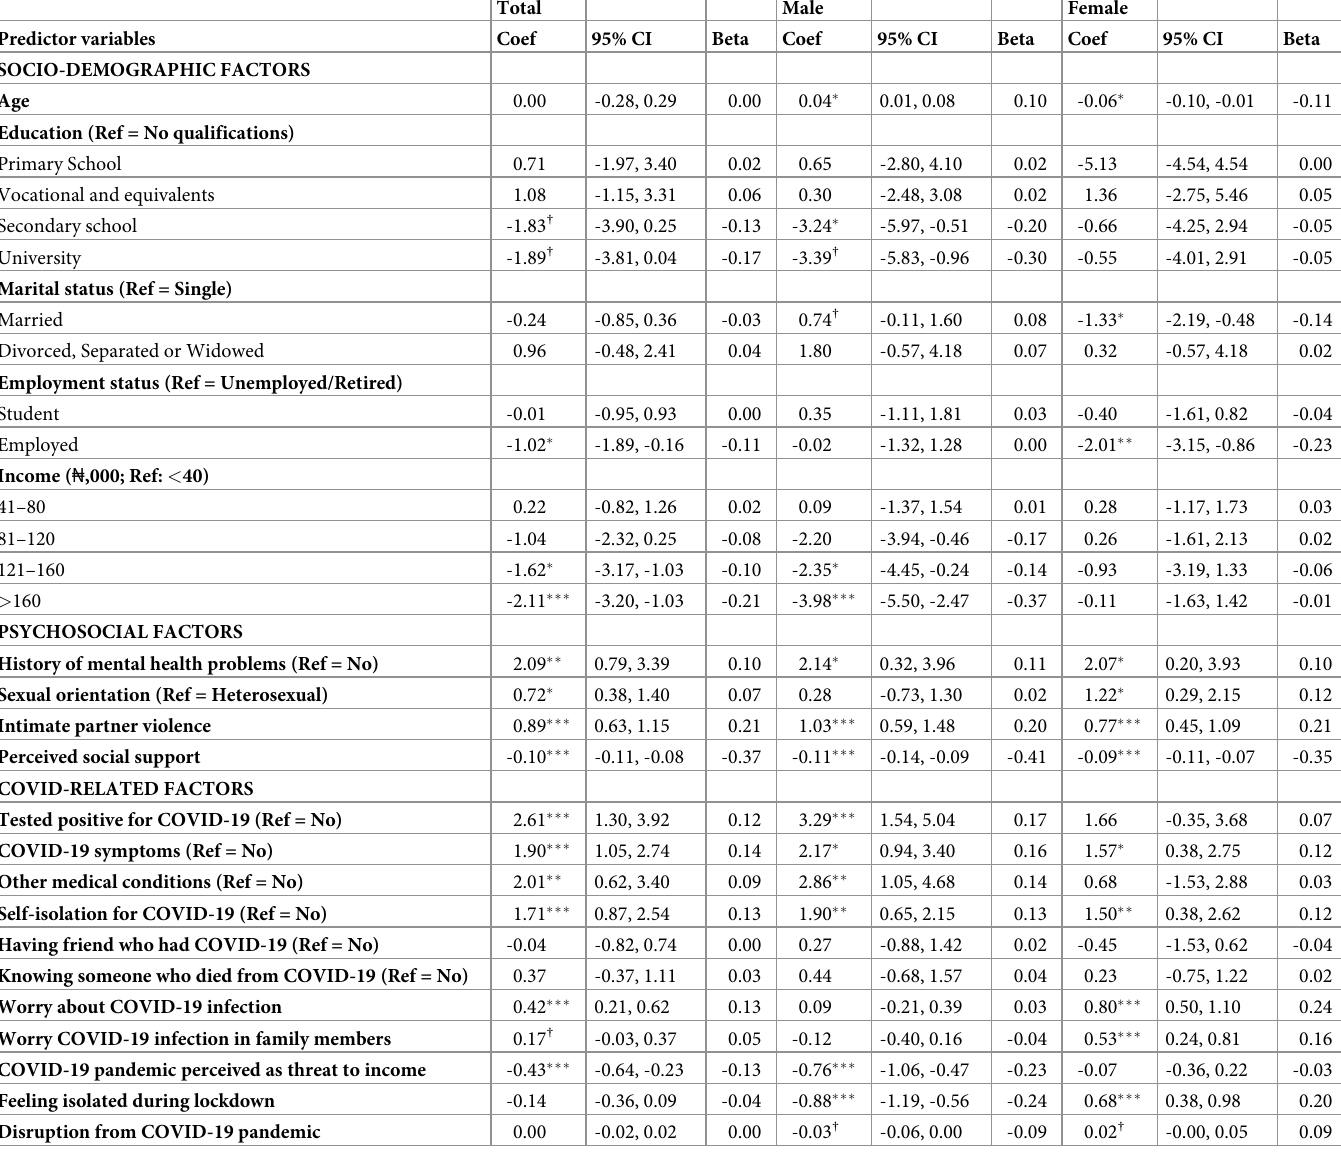
Table 2. Univariate associations between anxiety symptoms and predictors with sex differences.